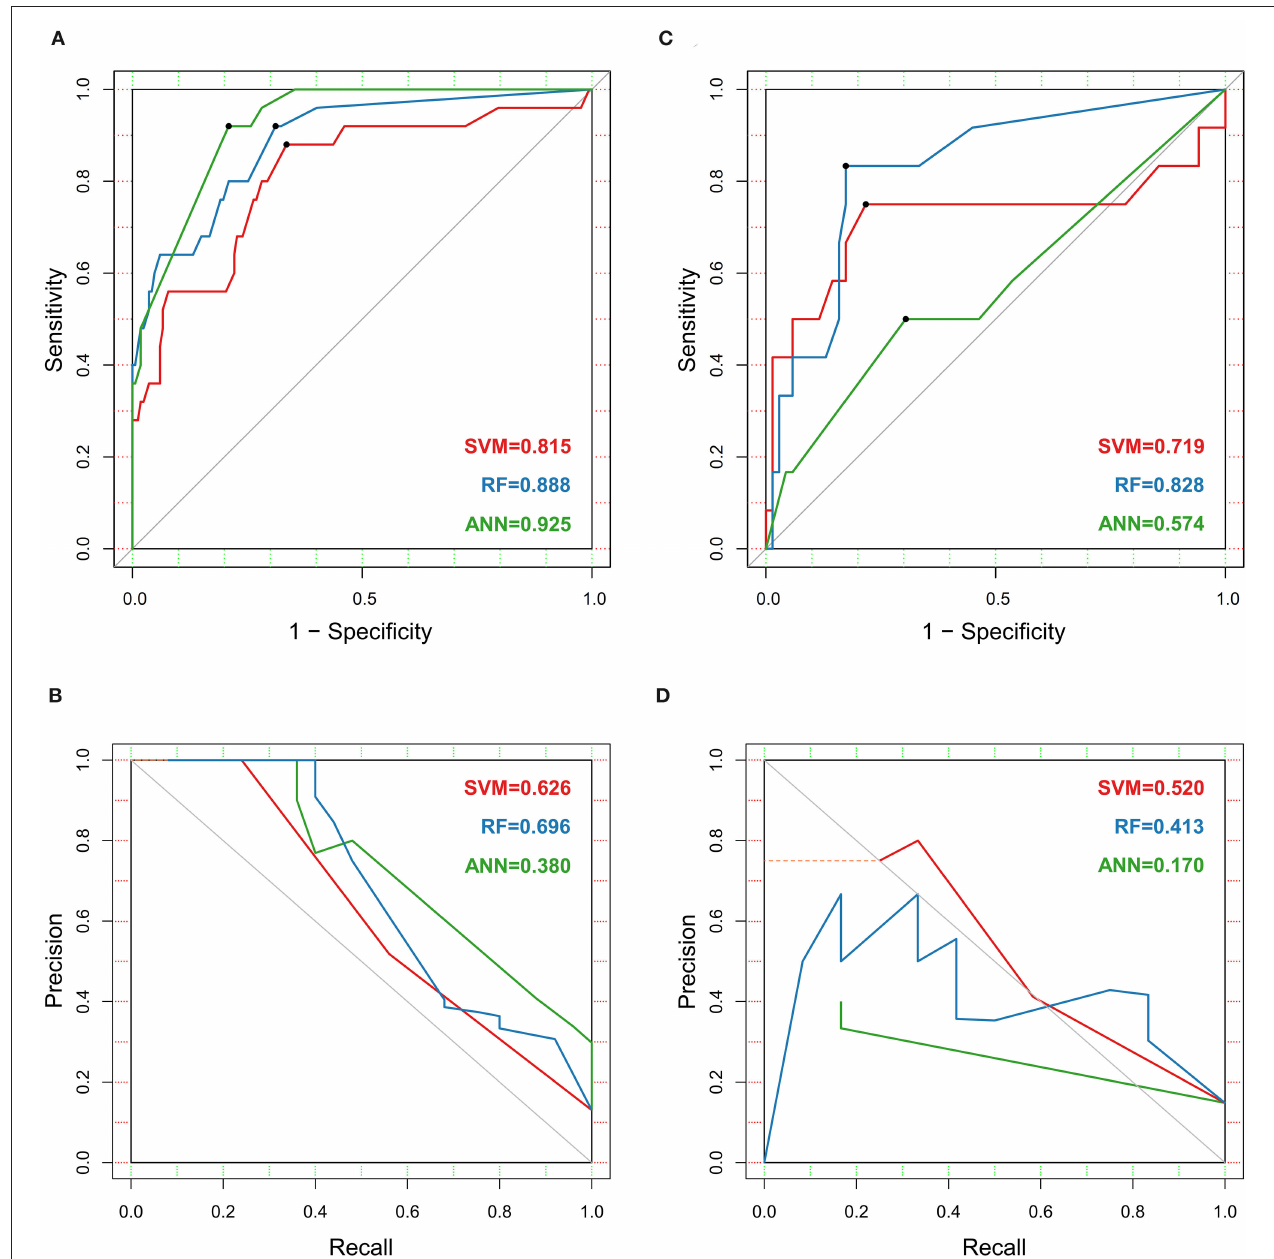
FIGURE 3 | The area under the receiver operating characteristic curve (AUROC) and precision-recall curve (AUPRC) of three machine learning models, which were trained using the support vector machine (SVM), random forest (RF), and artificial neural network (ANN) algorithms. (A) AUROC of the training set. (B) AUPRC of the training set. (C) AUROC of the testing set. (D) AUPRC of the testing